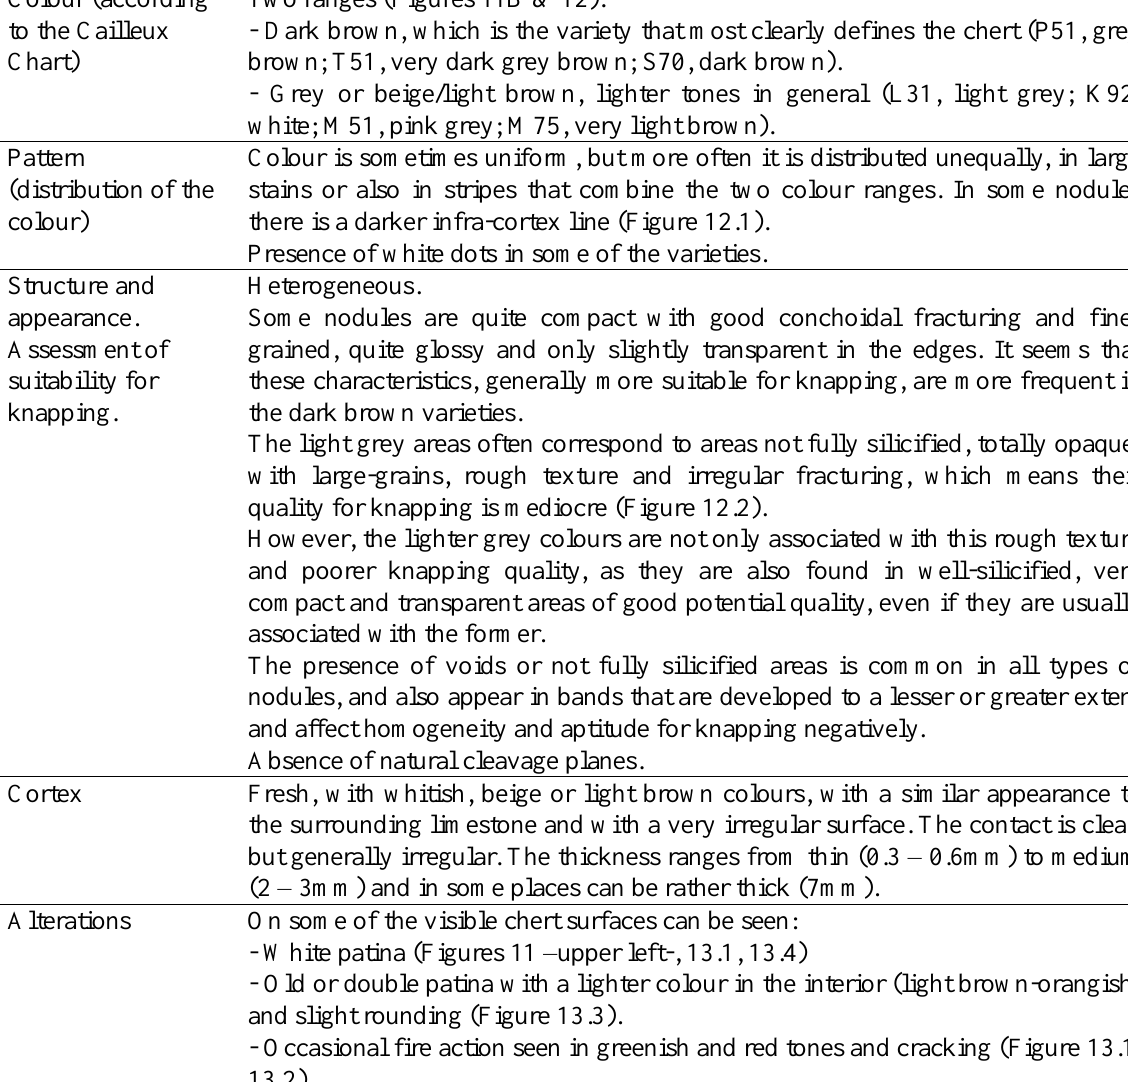
Table 1. Macroscopic features of Las Canteras nodules Colour (according to the Cailleux